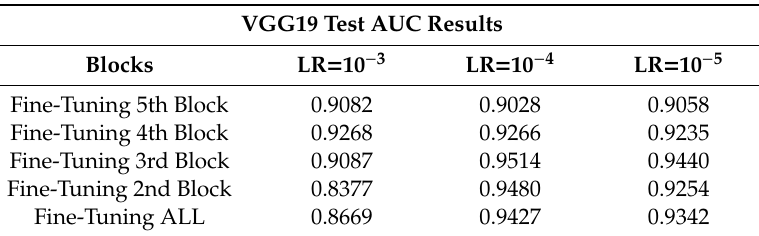
Table 3. Results of the VGG19